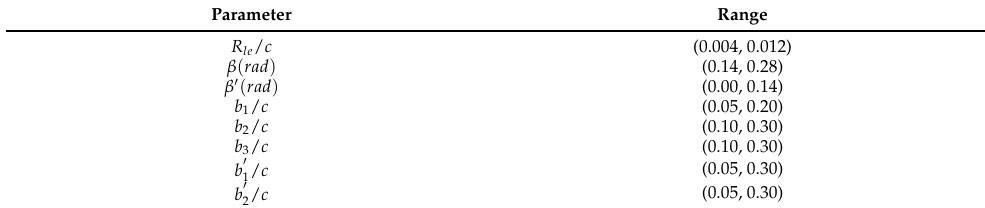
Table 8. Range of design parameter.